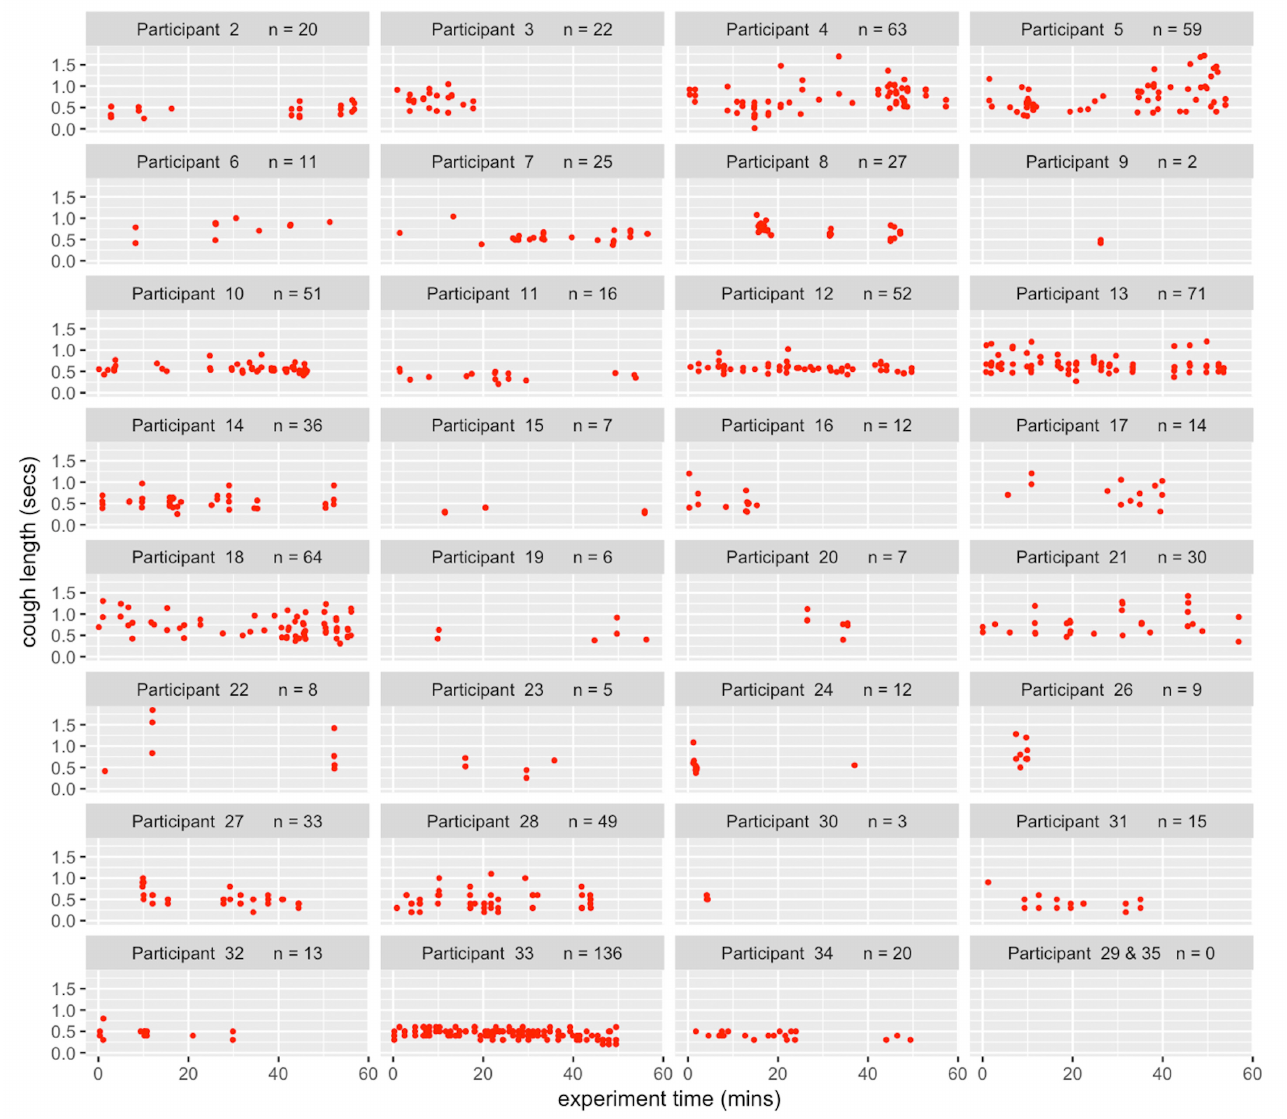
Figure 5. Plot of recorded coughs for each participant throughout the